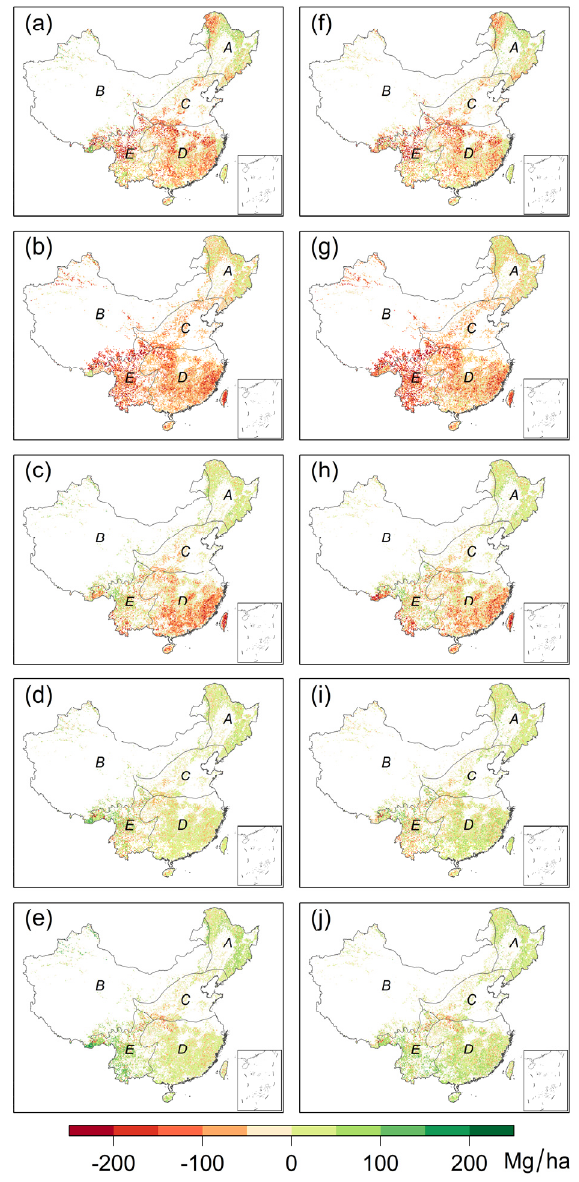
Figure 6. Maps of AGB density differences. ( a – e ) Difference maps between WT-AGB and each of the participating AGB datasets from ( a ) Saatchi, ( b ) Su, ( c ) Baccini, ( d ) Santoro, and ( e ) Huang. ( f – j ) Difference maps between RF-AGB and each of the participating AGB datasets from ( f ) Saatchi, ( g ) Su, ( h ) Baccini, ( i ) Santoro, and ( j ) Huang. Between the two hybrid maps, the agreement over Region A was good with relative differences <10% and was poorest in Region B (Figure 7, Table 2), where temperate steppe and desert are dominant. The mean AGB densities of both hybrid products were higher than the five participating AGB datasets in Region A and had a similar range for the other four regions (see Figure 7). All seven products showed the highest mean AGB density in Region E, where the mean AGB density estimated by Su was more than 75% higher than that of the two hybrid products. Furthermore, the spread of data (bar height in Figure 7) did not show noticeable differences between the two hybrid datasets and was smaller than the spread of estimates in the Saatchi and Baccini estimates for most regions. Across the different regions in China, the relative error (defined as the ratio of standard deviation to mean) varied from 19% in Region D to 44% in Region A for the RF approach and from 11% in Region A to 53% in Region B for the WT approach (Table 2).